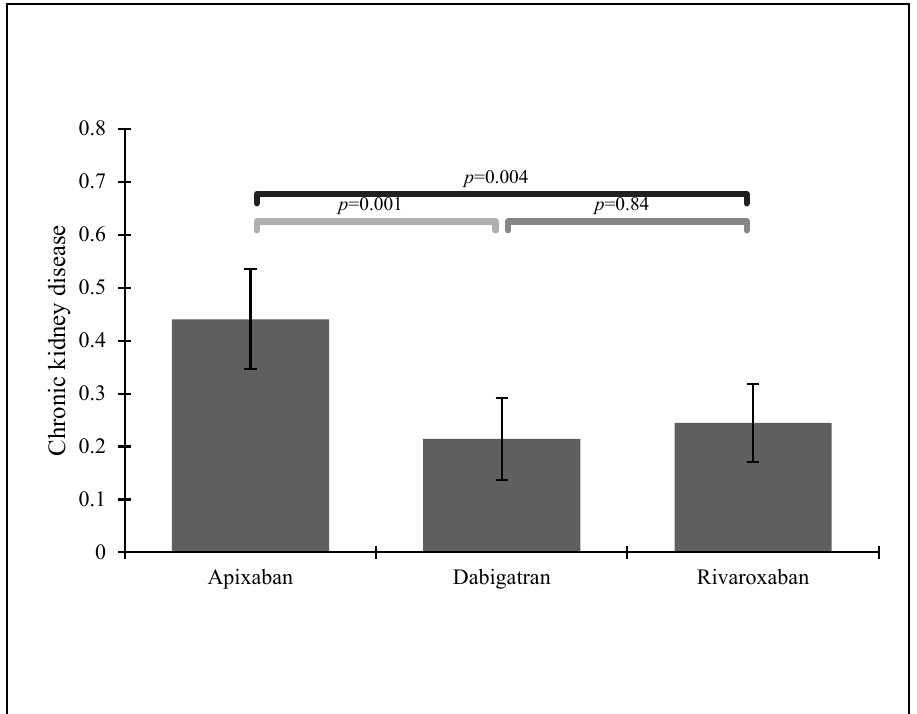
Figure 3. NOAC administration in patients with a previous stroke history and chronic kidney dis- ease. Patients taking acetylsalicylic acid (ASA) and those suffering from hyperlipidemia most often received rivaroxaban—see Figures 4 and 5.